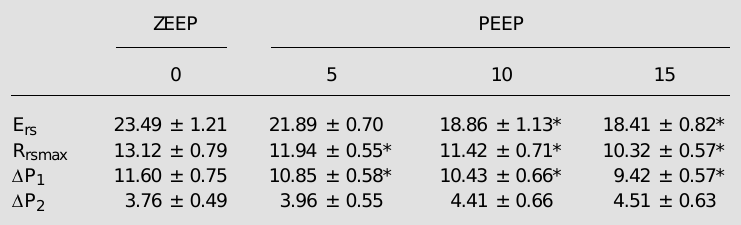
Table 1 - Respiratory mechanical